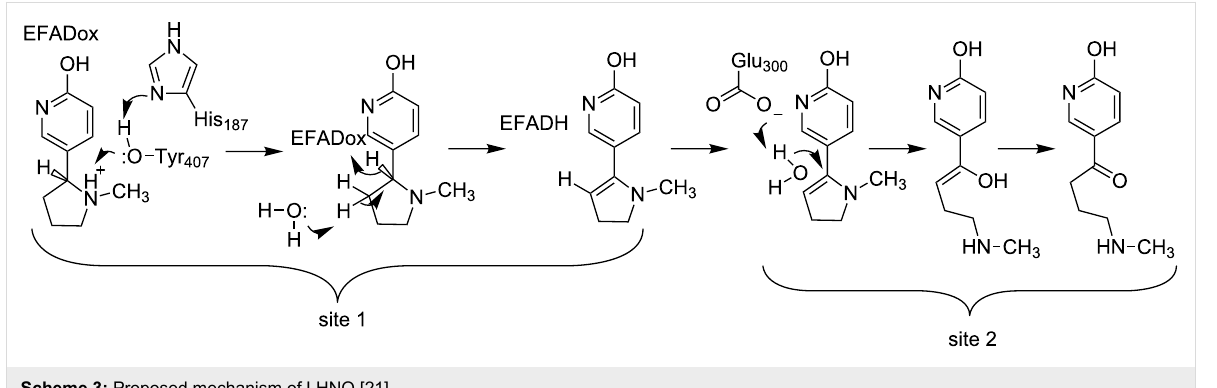
Scheme 3: Proposed mechanism of LHNO [21].